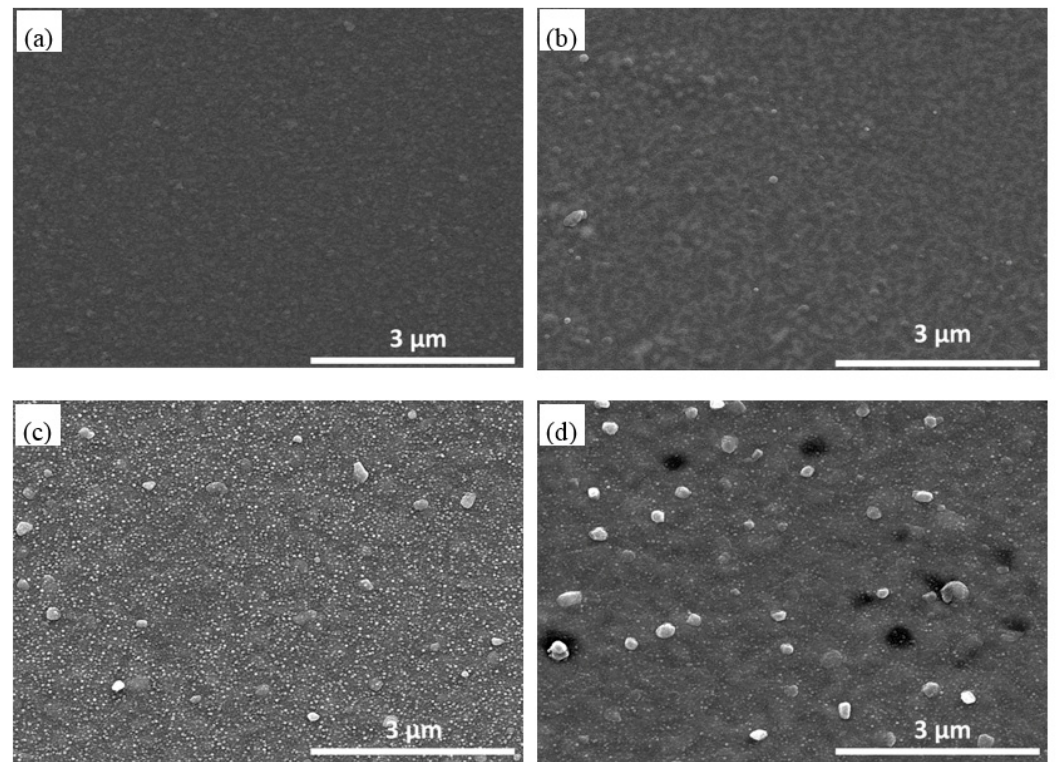
Figure 5. Surface topography of AlN/Pt/ZnO(RT)/LGS samples ( a ) before; and ( b ) after 1000 °C resistance measurement. Surface topography of AlN/Pt/ZnO(600 °C)/LGS samples; ( c ) before; and ( d ) after 1000 °C resistance measurement.